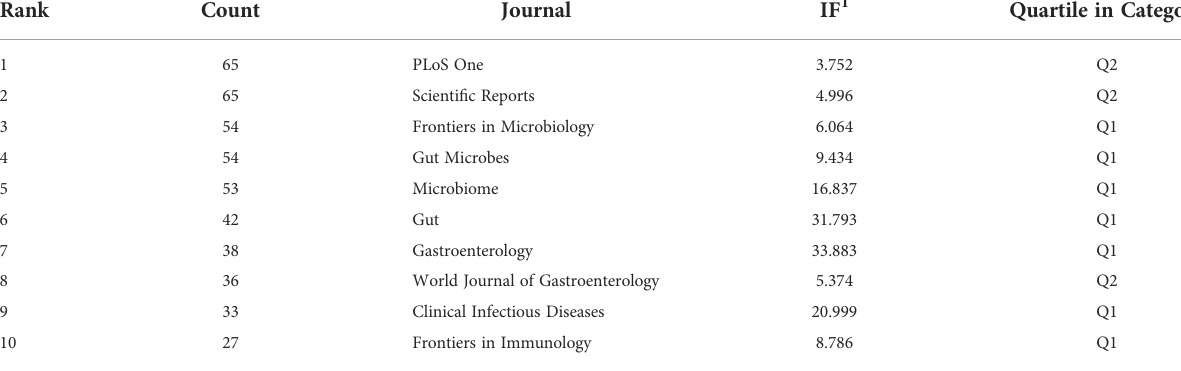
TABLE 2 Journals with the most published FMT-related